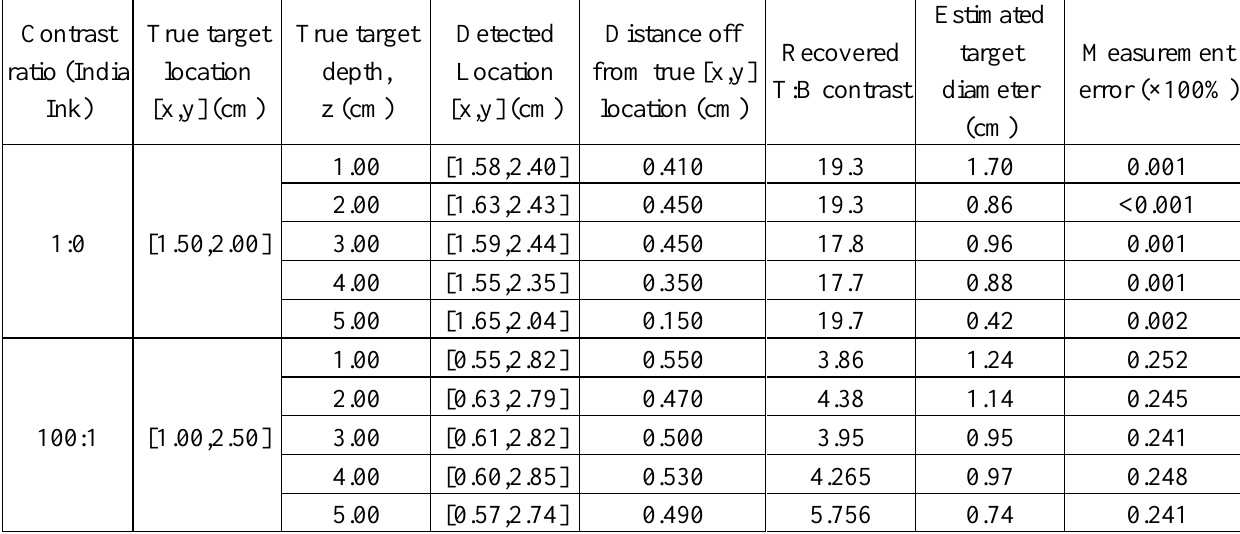
Table 3. Quantitative details of the detected target location, size, recovered T:B contrast and measurement errors for different experimental cases using the Gen-2 imager towards transillumination imaging